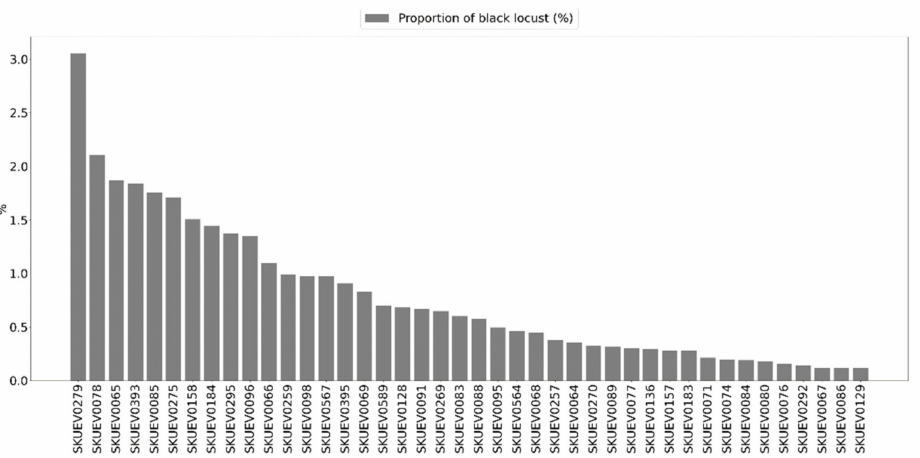
Figure 14. Proportion of black locust stands within 1 km buffer zone of the Natura2000 sites (SKUEV represent name of the Nature2000 sites (absences of black locust in Natura2000 sites, e.g., 0% propor- tions were omitted for better visualitzations; they represent 24